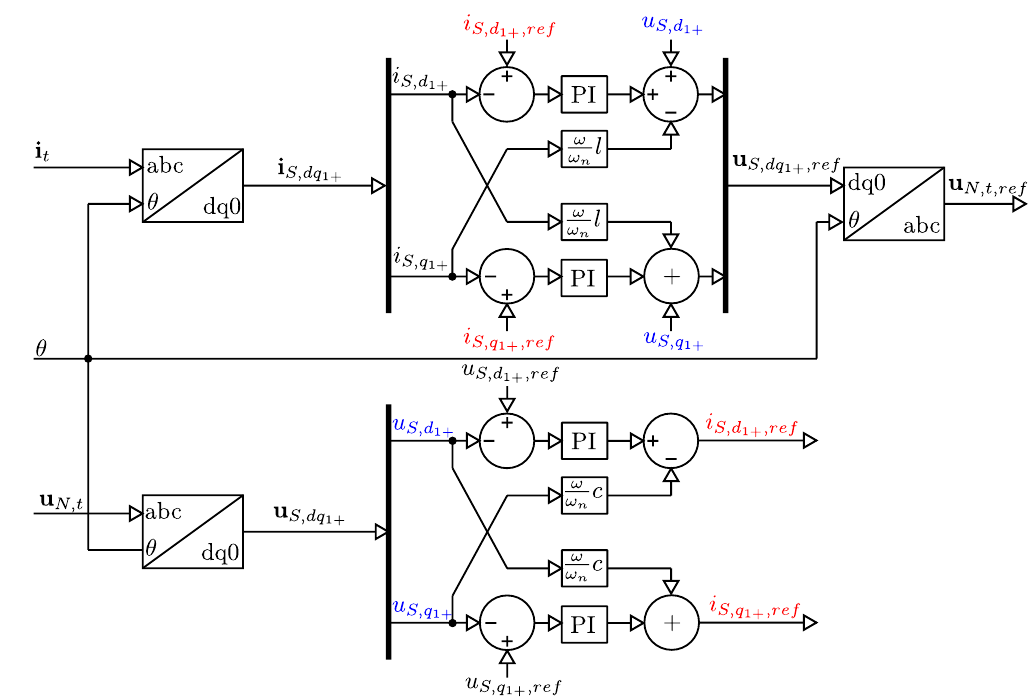
and u S , q as well as the connection between i S , d 1 + 1 +